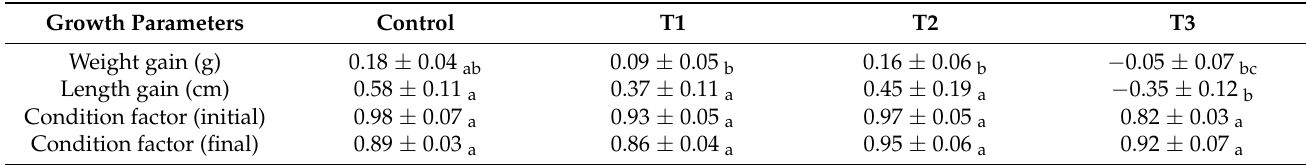
Figure 5. RNA and DNA ratio of 14-day exposed muscle and gills. Control: 0.0 mg/L, T1: 2.5 mg/L, T2: 15 mg/L and T3: 30 mg/L. Table 3. Growth parameters of arsenic-exposed rohu carp. Data represented as Mean ± Std. Error and analyzed by one-way ANOVA and Tukey’s HSD post-hoc test. Data with different subscript lowercase letters represent significant differences ( p < 0.05) among treatments.